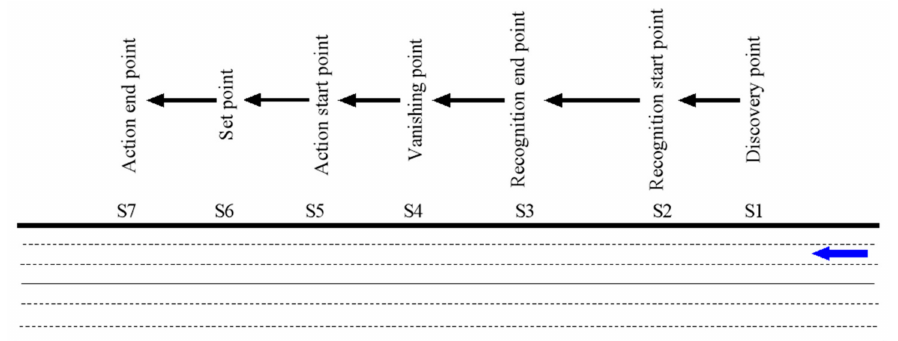
Figure 2. The driver’s visual recognition